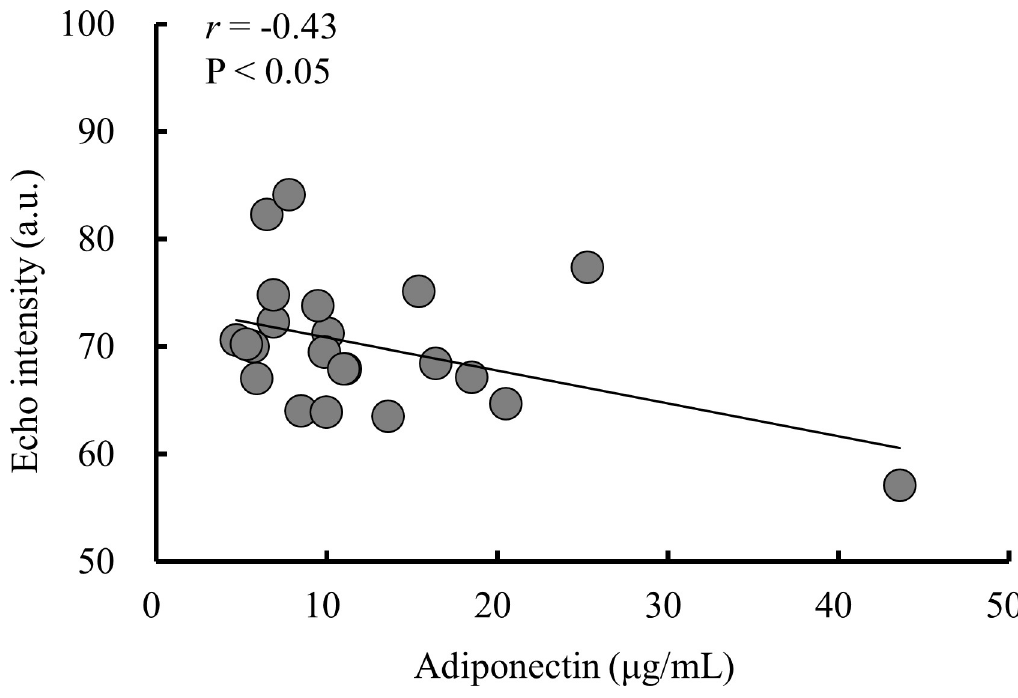
Fig 2. Relationship between echo intensity and adiponectin.